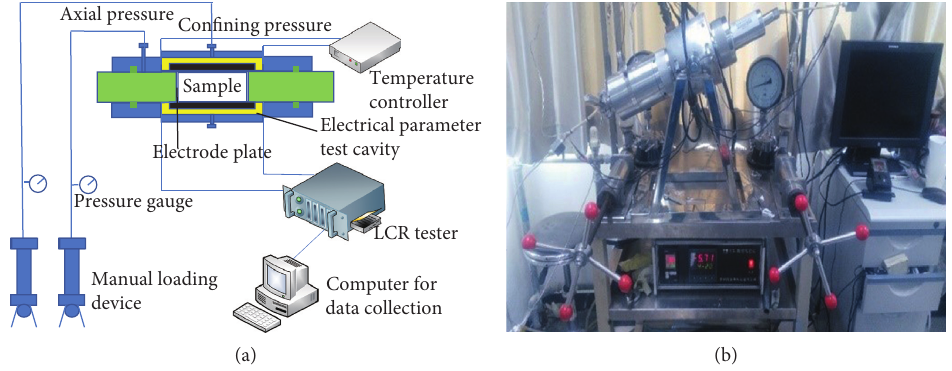
Figure 1: Diagram of loaded coal resistivity test system. (a) Schematic diagram. (b) Physical